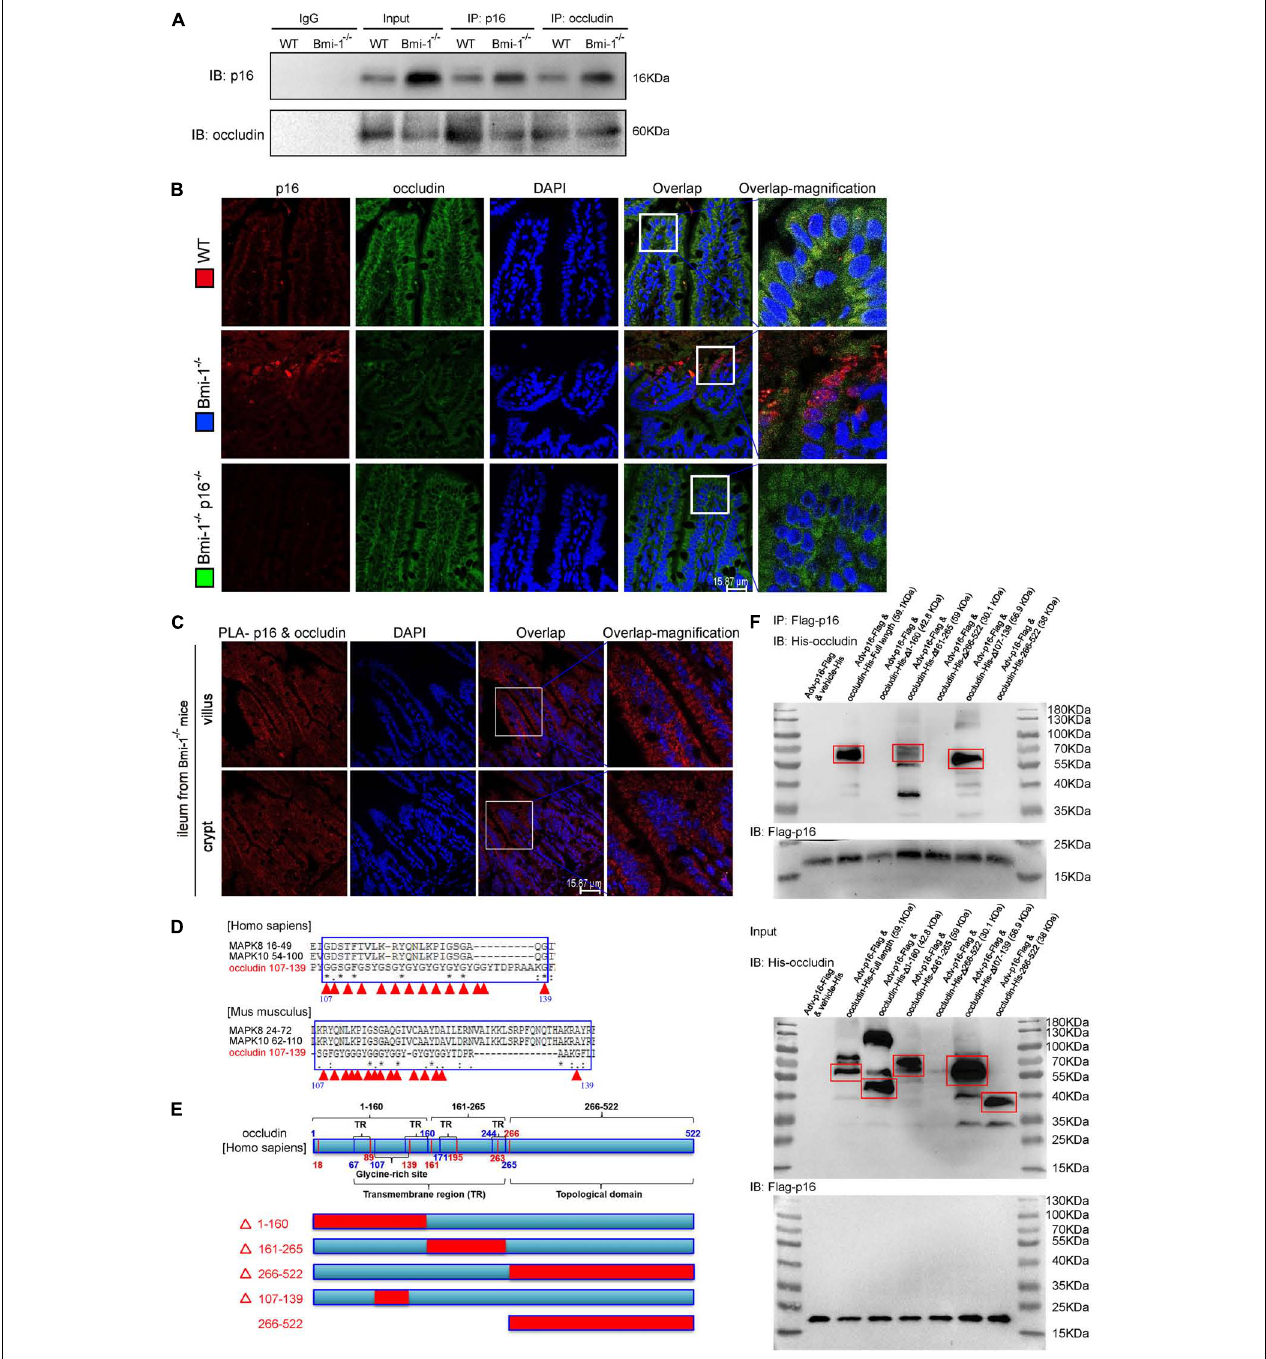
FIGURE 3 | P16 combined with occludin in the cytoplasm of intestinal epithelium cells in Bmi-1 − / − mice for blocking reparation of TJ. The experiments were carried out on the 7-week-old Bmi-1 − / − , and WT mice. (A) Intestinal epithelial proteins from WT and Bmi-1 − / − mice were extracted for anti-p16 or anti-occludin immunoprecipitation. Western blots were used for detecting p16 and occludin. (B) Representative micrographs showing immunofluorescence double-labeling of p16 and occludin in ileum from 7-week-old Bmi-1 − / − , Bmi-1 − / − p16 − / − and WT mice. (C) Representative micrographs of Duolink PLA for interaction between p16 and occludin in villus and crypt of ileum from Bmi-1 − / − mice, with DAPI staining nuclei. (D) Analysis with https://www.uniprot.org/align showed an extremely similar domain among occludin, MAPK8, and MAPK10 in human and mouse, with red triangle showing glycine site, “*” indicating a single and fully conserved residue, “:” indicating residue with very similar properties, and “.” indicating residue that is weakly similar. (E) Protein domain of human occludin. (F) The 239T cells were transfected with Flag-p16 (human) overexpressed adenovirus and the His-tagged plasmid of full length, 1–160–mutant ( (cid:77) 1–160), 161–265–mutant ( (cid:77) 161–265), 266–522–mutant ( (cid:77) 266–522), 107–139–mutant ( (cid:77) 107–139), or 266–522–truncated fragment for human occludin . Cell proteins were extracted for anti–Flag-Tag immunoprecipitation and detected anti-Flag and anti-His antibodies with Western blots. The input proteins also detected anti-Flag and anti-His antibodies with Western